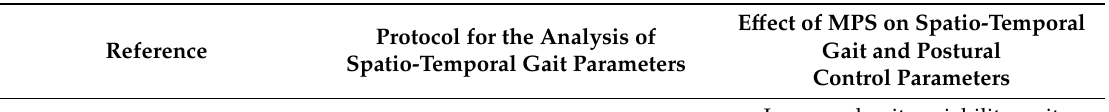
Table 3. Characteristics of the protocol for the analysis and e ff ect on spatio-temporal gait and postural control